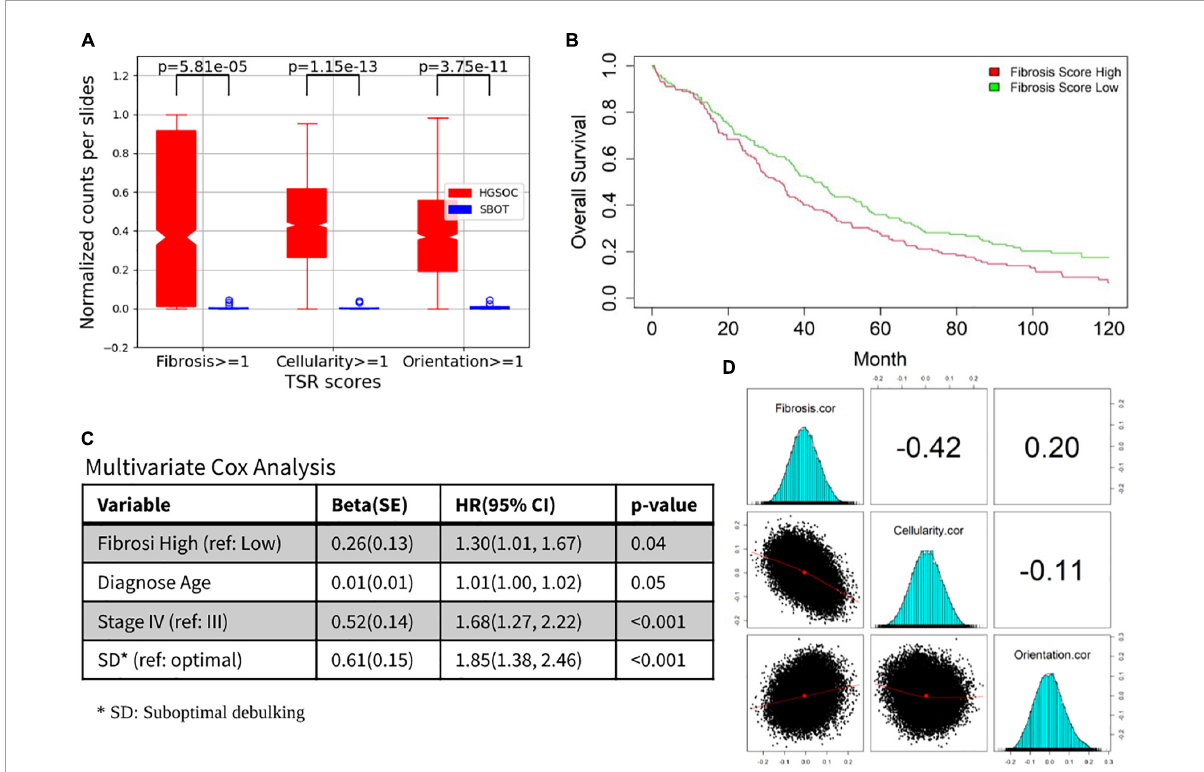
FIGURE5 Prognosis and molecular associations of fibrosis score. (A) Tumor-stroma reaction (TSR) score boxplots for HGSOC and SBOT groups. (B) Overall survival differences between fibrosis high vs. low. (C) The prognostic association for other established prognostic factors (age at diagnosis, stage and residual tumor after surgical debulking). (D) Correlation between fibrosis/cellularity/orientation and molecular